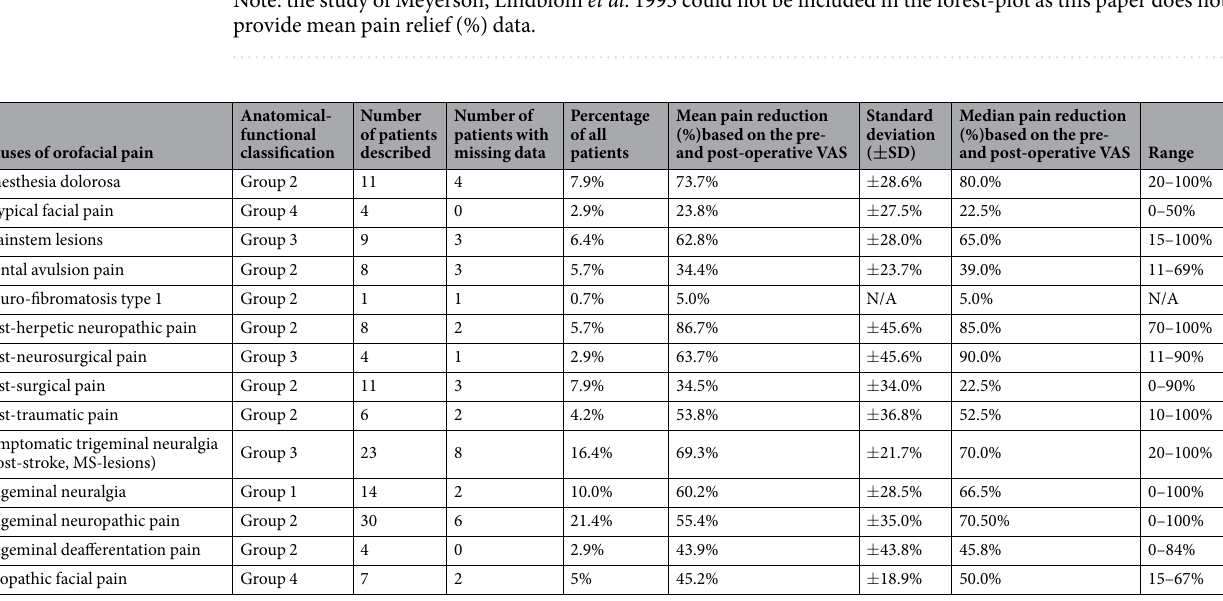
Table 3. Overview of diagnoses causing orofacial pain and efficacy of iMCS. Group 1 = Absence of intrinsic trigeminal nerve lesion; Group 2 = Trigeminal nerve lesion; Group 3 = Nuclear- and supranuclear lesion; Group 4 = Dysfunctional pain syndrome; N/A = Not applicable; VAS = Visual analogue